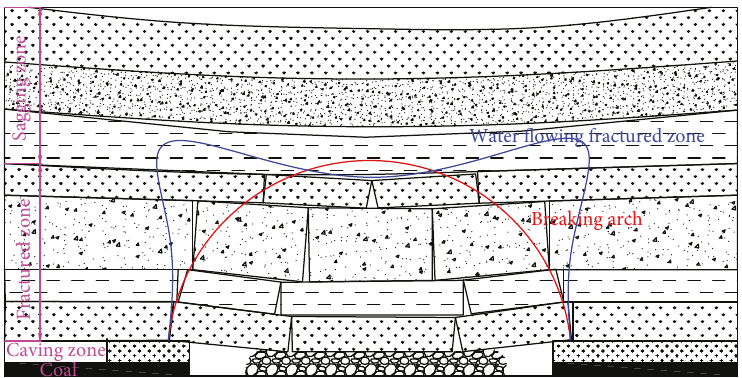
Figure 1: Mechanical structure model of the breaking arch in the